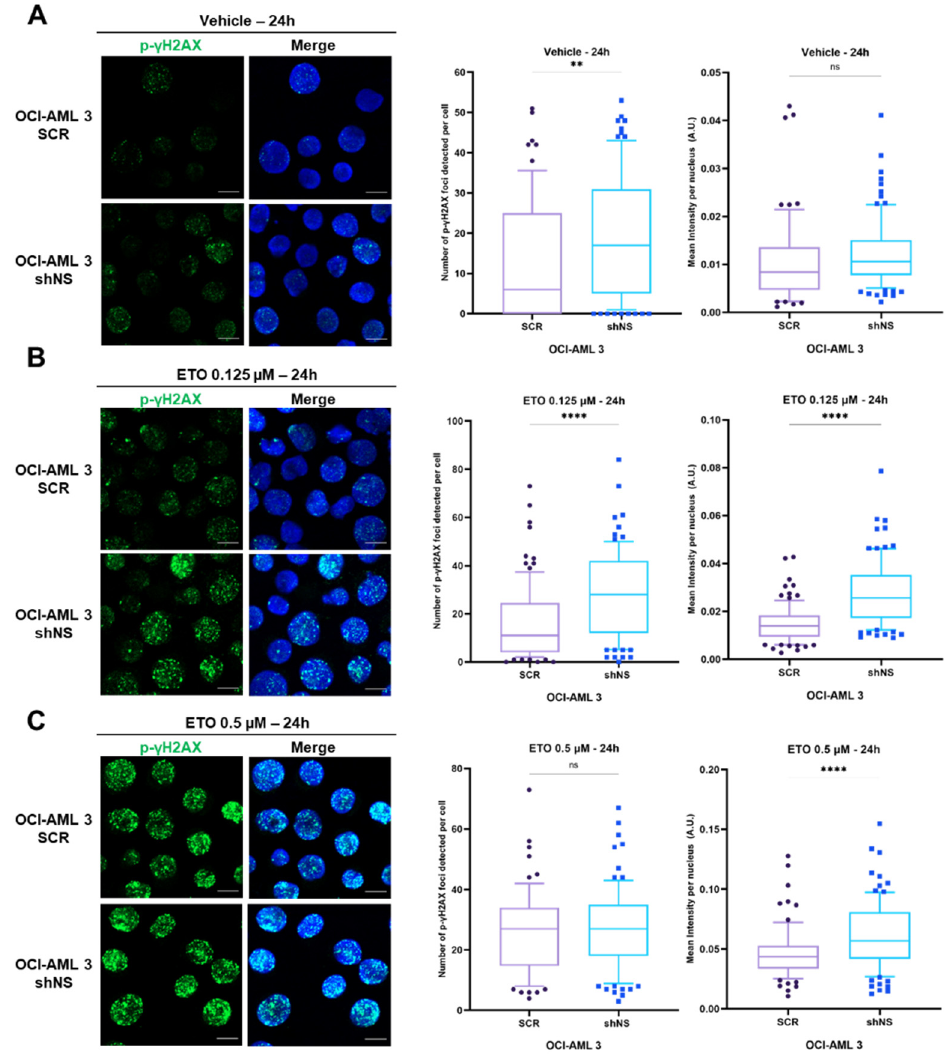
Figure 4. Etoposide treatments together with NS silencing increase DNA damage foci in OCI-AML 3 cell lines. Representative immunofluorescence images (scale bar = 10 µm) of OCI-AML 3 cells not silenced (SCR) and silenced (shNS) for NS protein under doxycycline induction after 24 h of DMSO 0.1% (vehicle) ( A ), 0.125 µM ( B ) or 0.5 µM etoposide ( C ) (ETO) treatments. Cells were stained with anti-p- γ H2AX antibody (green dots) to evaluate DNA damage foci within cell nuclei. Merge images are reported for each figure in which, beside anti-p- γ H2AX foci, Hoechst 33342 (blue) staining corresponds to cell nuclei. For each condition considered, the distribution of the number of foci detected per single cell (left) and the distribution of mean intensity per nucleus per cell (right) were analyzed with FoCo software (10 images taken) for, respectively, SCR and shNS OCI-AML 3 cells after 24 h of DMSO 0.1% (vehicle) ( A ), 0.125 µM ( B ) or 0.5 µM ETO ( C ) treatments. In both box plots represented, medians for each distribution are highlighted. ns, not significant; ** p < 0.01; **** p < 0.0001, non-parametric Student’s t -test.